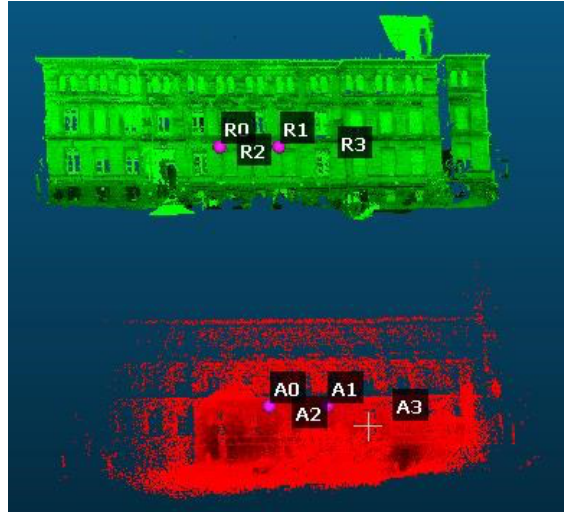
Figure 6: Reference point cloud (green) and MMS point cloud (red) before alignment and segmentation